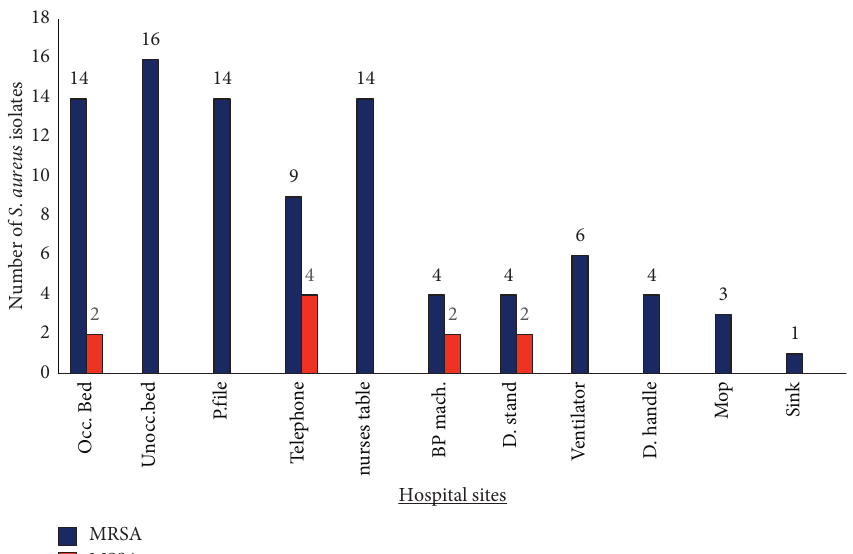
Figure 1: Prevalence of S. aureus (MRSA and MSSA) isolates sampled on eleven hospital sites within the wards and public hospitals